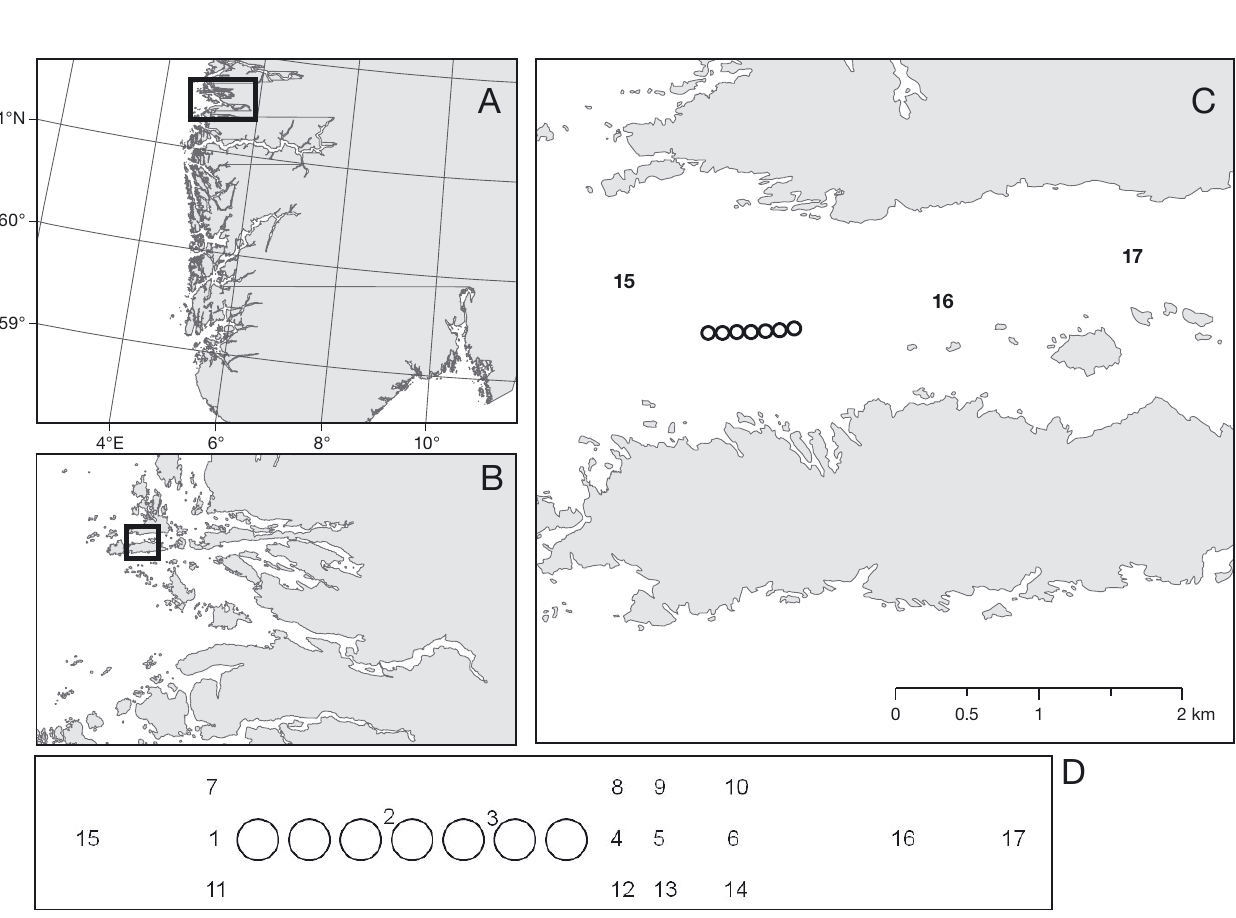
Fig. 1. (A,B) Location of study site in western Norway. (C) Study site (Flåtegrunnen), showing the location of salmon net pens (circles) and reference sites (Stns 15−17). (D) Outline of the grid survey; circles represent the sal mon cages, and numbers indicate the sampling stations inclu ded in the syste matic water sampling cam paigns (see also Table